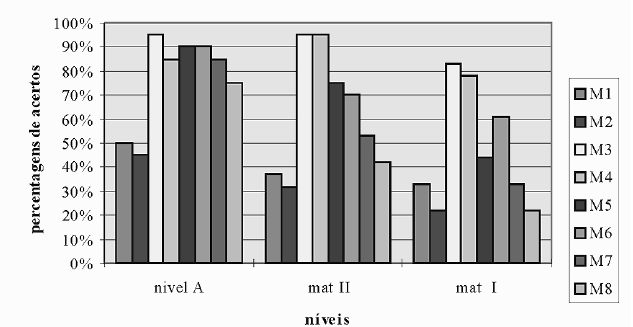
Figura 3. Percentagens de acertos por